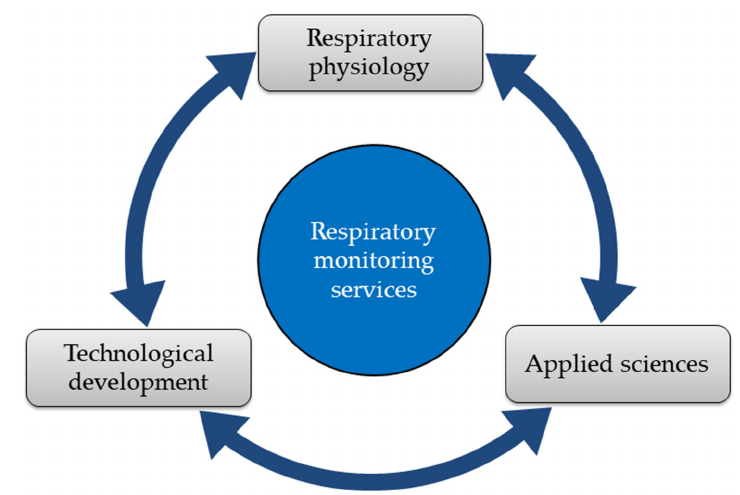
Figure 2. Schematic representation of the interactions between respiratory physiology, applied sciences, and technological development. The Figure shows how fruitful synergies between different disciplines are essential for the development of respiratory monitoring services.